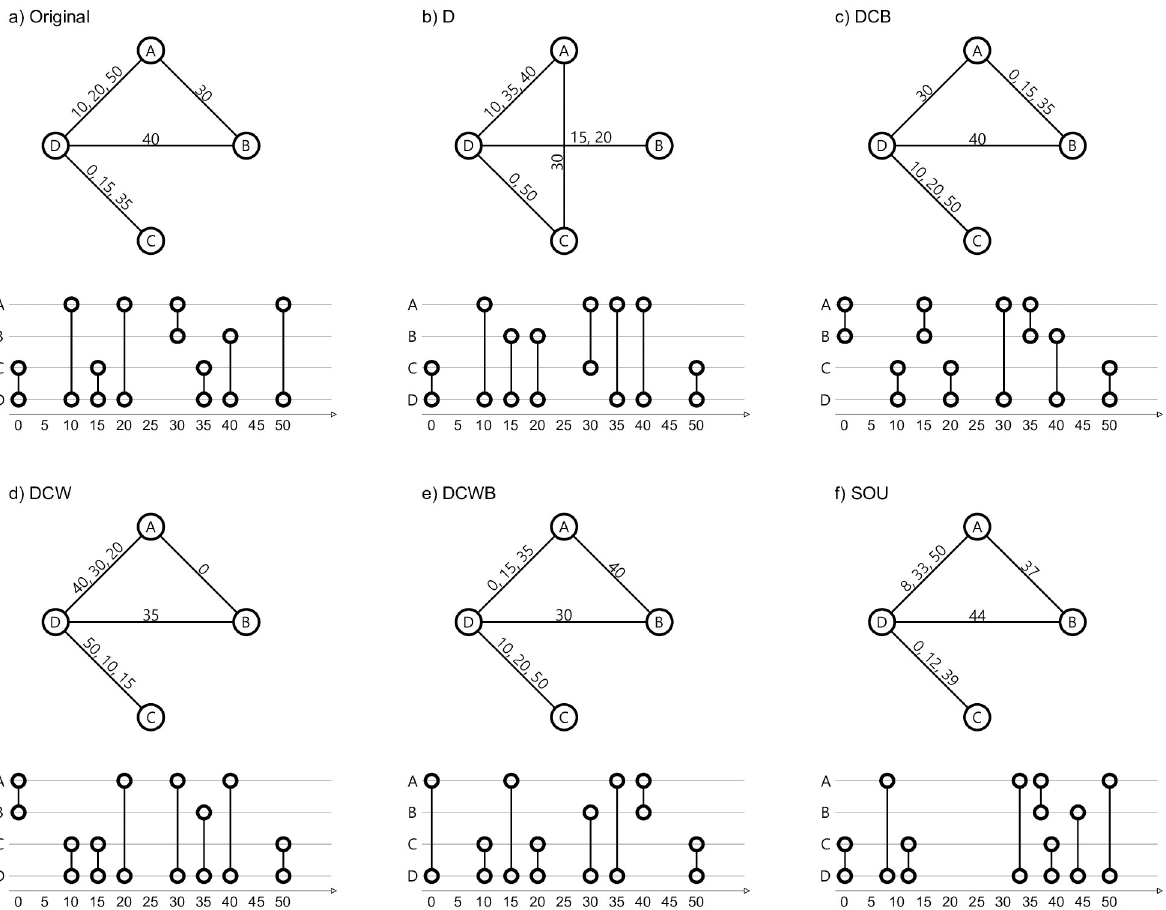
Fig 1. Visualization of a sample original network and its shuffled counterparts. For each network, the upper figure demonstrates the aggregated network with times of contacts as labels on edges. And the lower figure demonstrates a timeline for vertices, while the vertical line denotes the existence of a contact between two vertices at that specific